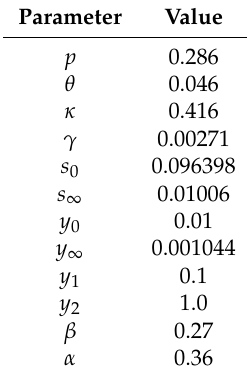
Table 2. PTW parameter set 7.